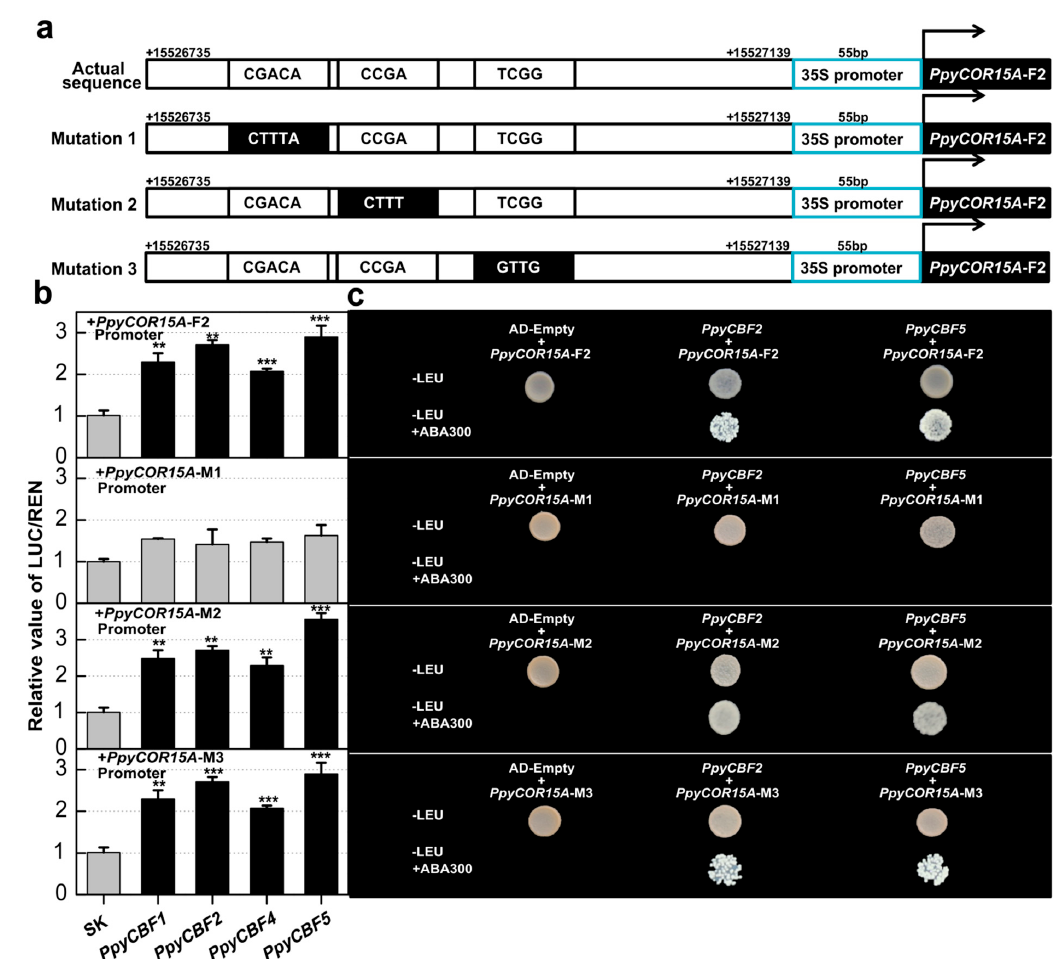
Figure 6. PpyCBFs can also bind at TCGAC binding site in the PpyCOR15A promoter. ( a ) Schematic diagrams of mutations at three different motif sites for PpyCOR15A promoters, indicated with mutation 1, 2, and 3. Possible CBF-binding sites in PpyCOR15A promoter are represented with white rectangles while mutations at these sites are represented by black rectangles. ( b ) Dual-luciferase assays were performed with actual and mutated promoters of the PpyCOR15A promoter. The ratio of LUC/REN of the empty vector (pGreenII 0029 62-SK) plus promoter was used as the calibrator (set as 1). Three independent experiments (with minimum four replicates) were performed to verify the results. Error bars show SEs with at least four biological replicates while asterisks show significant differences with empty SK (** p < 0.01, *** p < 0.001). ( c ) Y1H assay was performed to check physical interaction of PpyCBFs 2 and 5 with actual and mutated promoters of PpyCOR15A . Yeast grows on synthetic dropout without leucine but having Aureobasidin A 300 (SD/ − leu + ABA300) indicating the possible direct interactions.